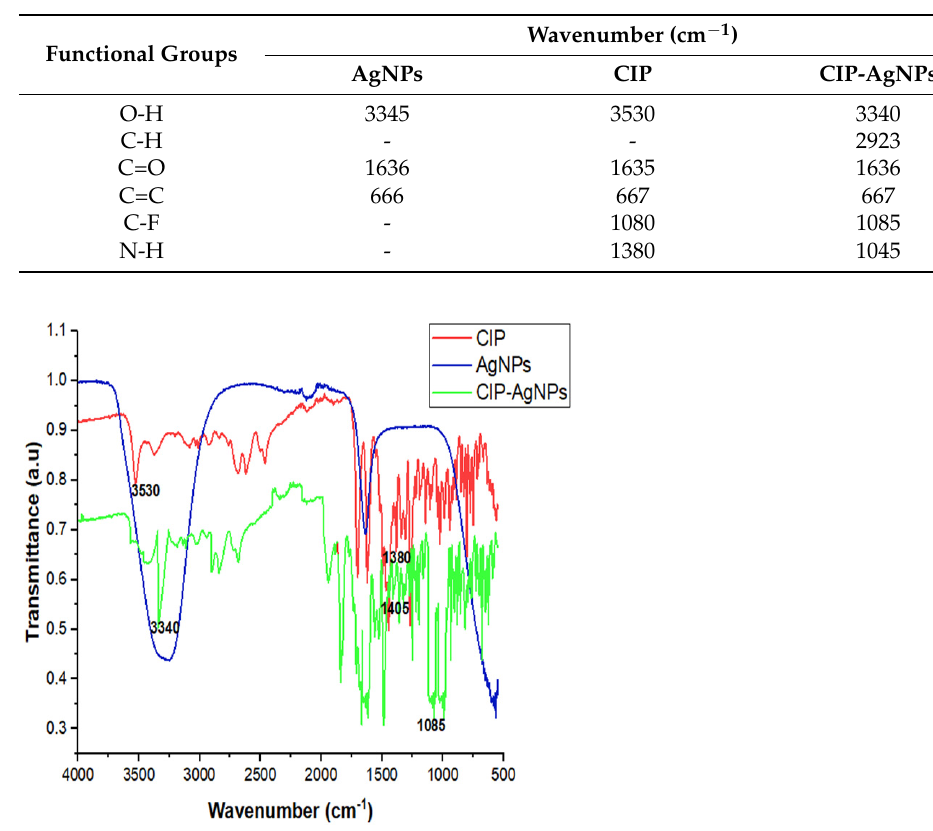
Figure 2. FTIR Spectra of CIP, AgNPs and CIP-AgNPs.